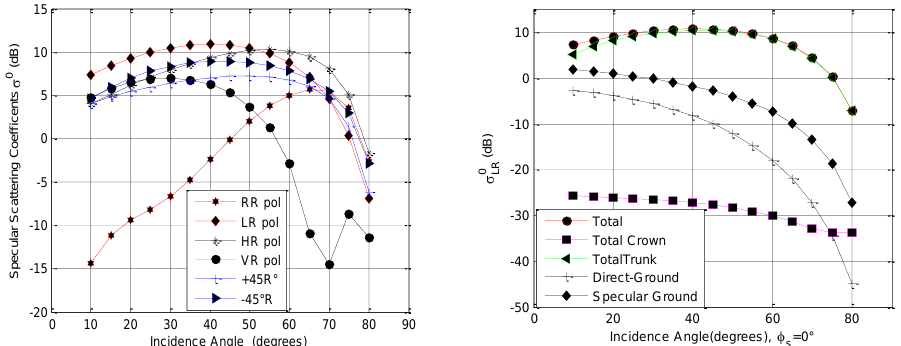
Figure 5. The vegetation specular scattering properties. The left figure is the coherent scattering at various polarizations. The right figure is the component scattering contribution to the total scattering.